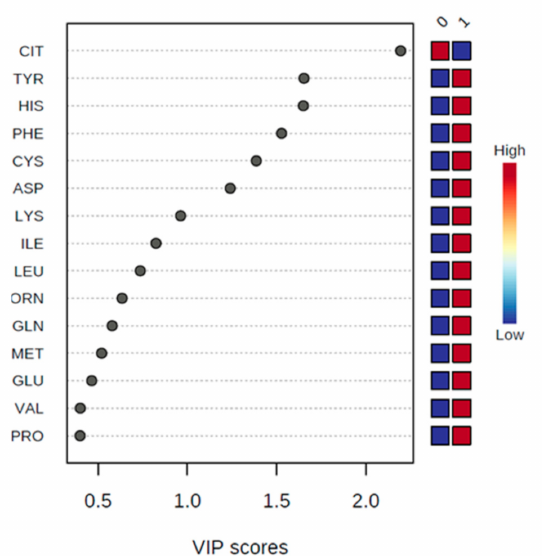
Figure 2. Important metabolites identified by PLS-DA. The colored boxes on the right indicate the relative concentrations of the corresponding metabolite in each group under study. The lower oxidative stress (Q1–Q3 nitrotyrosine) group is referred to by 0; the highest oxidative stress (Q4 ni- trotyrosine) group’s PLS-DA (partial least-squares discriminant analysis) is referred to by 1; VIP, variable importance in the projection.